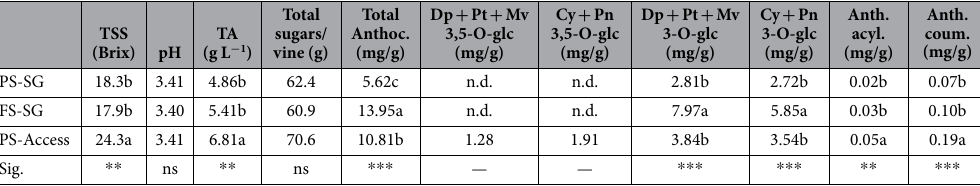
Table 5. Must composition recorded at harvest on SG (susceptible clone R10) and accession 72-096 (resistant). PF = partially sprayed. FS = fully sprayed. Anthocyanins data expressed as mg of malvidin-3-O-glucoside equivalent per g of skin dry weight. Abbreviations: Anth: anthocyanins, Dp: delphinidin, Cy: cyanidin, Pt: petunidin, Pn: peonidin, Mv: malvidin, acyl: acylated, coum: coumarated, glc: glucoside, n.d.: not detected. ** and *** denote significant differences between treatments at P < 0.01 and 0.001 according to within column mean separation performed with SNK test and showed by small letters. ns = not significant.